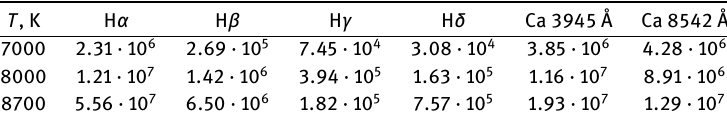
Table 1. Fluxes in the hydrogen and calcium lines in the stationary model. Here CaII 3945 Å column represents total flux in H and K CaII lines. The second row of the table at T = 8000 K is closest in terms of the fluxes in the H α and Ca II lines for stellar